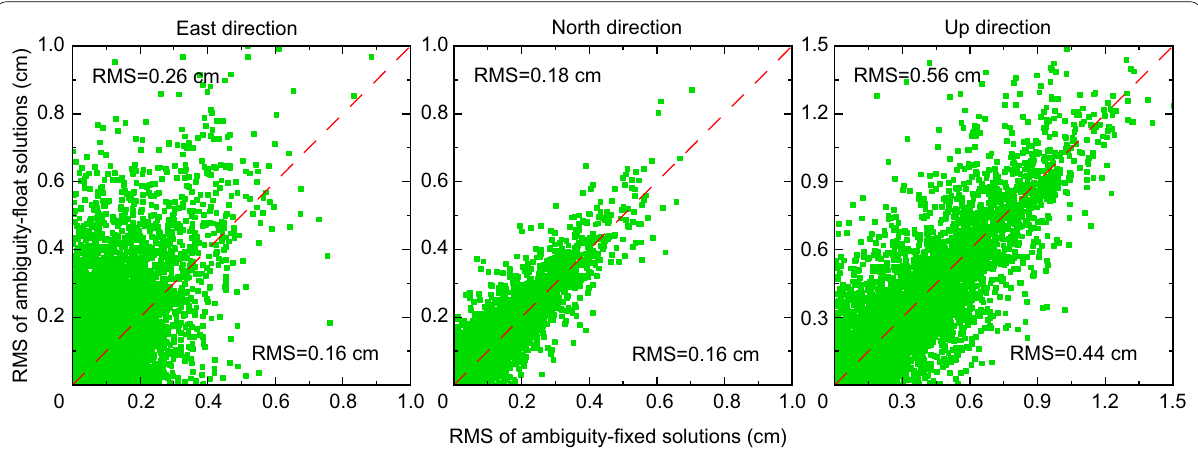
Fig. 5 RMS of position difference with IGS weekly solutions. One point represents a solution at a station on a day